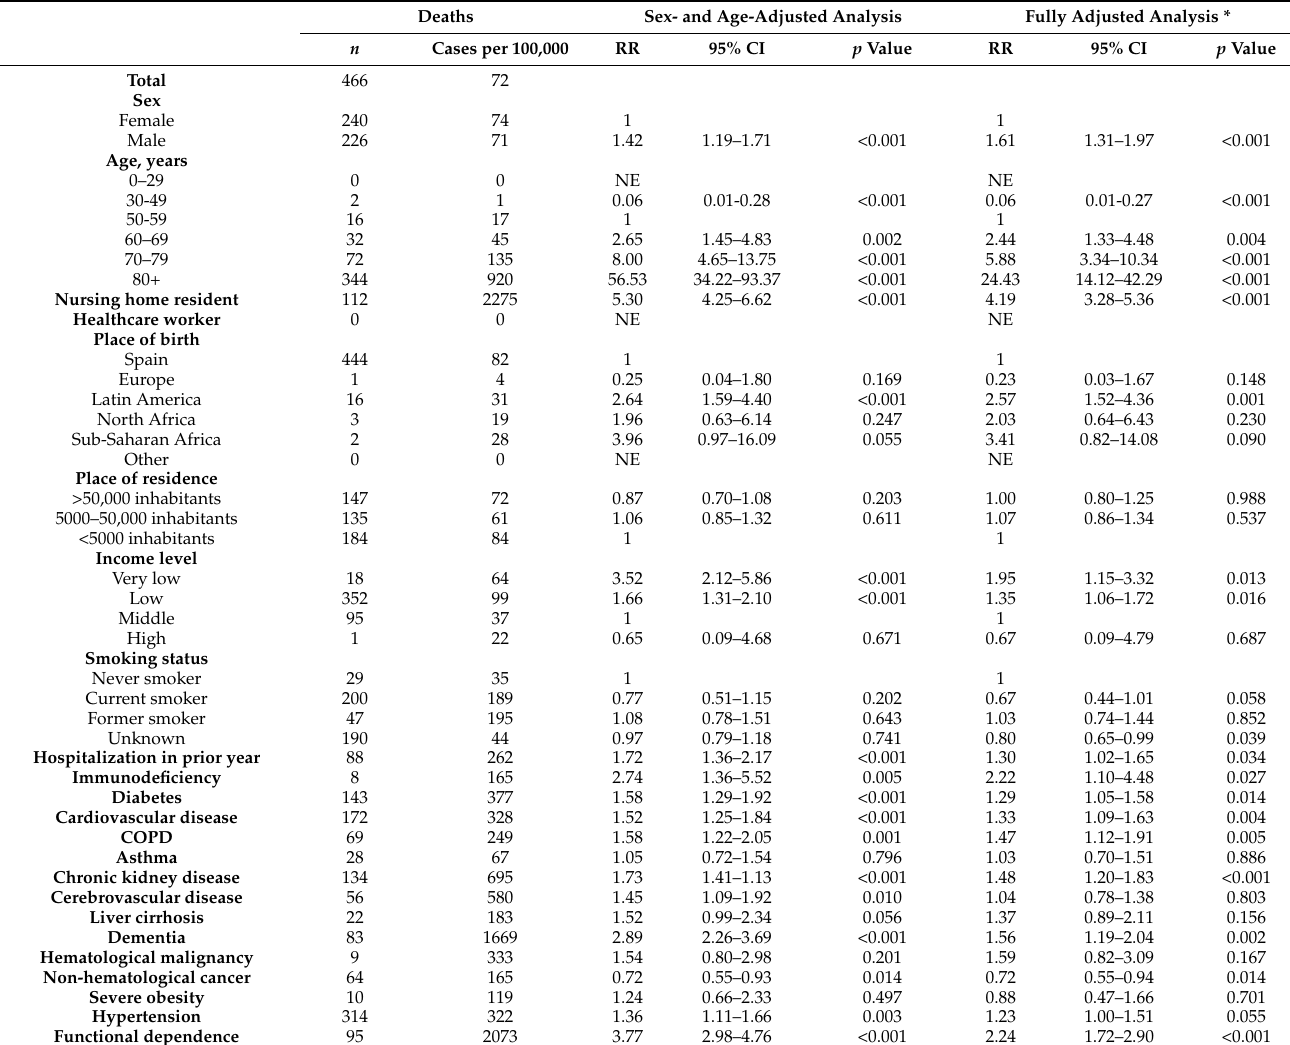
Table 4. Association between potential predictive factors and death from COVID-19 in the general population